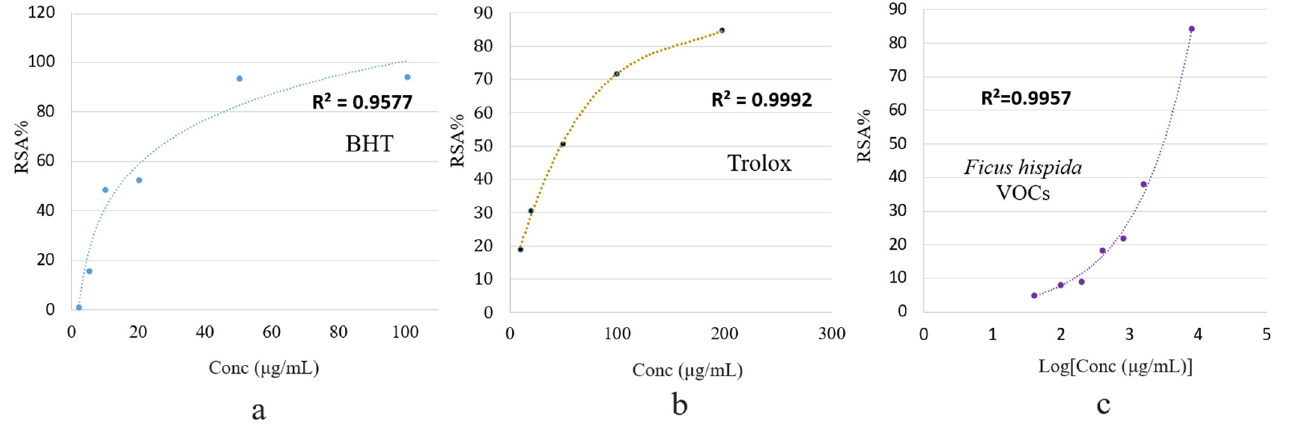
Figure 4. Percentage of radical scavenging activity (RSA%) of BHT ( a ), trolox ( b ), and F. hispida volatile organic compounds ( c ) using the DPPH method.